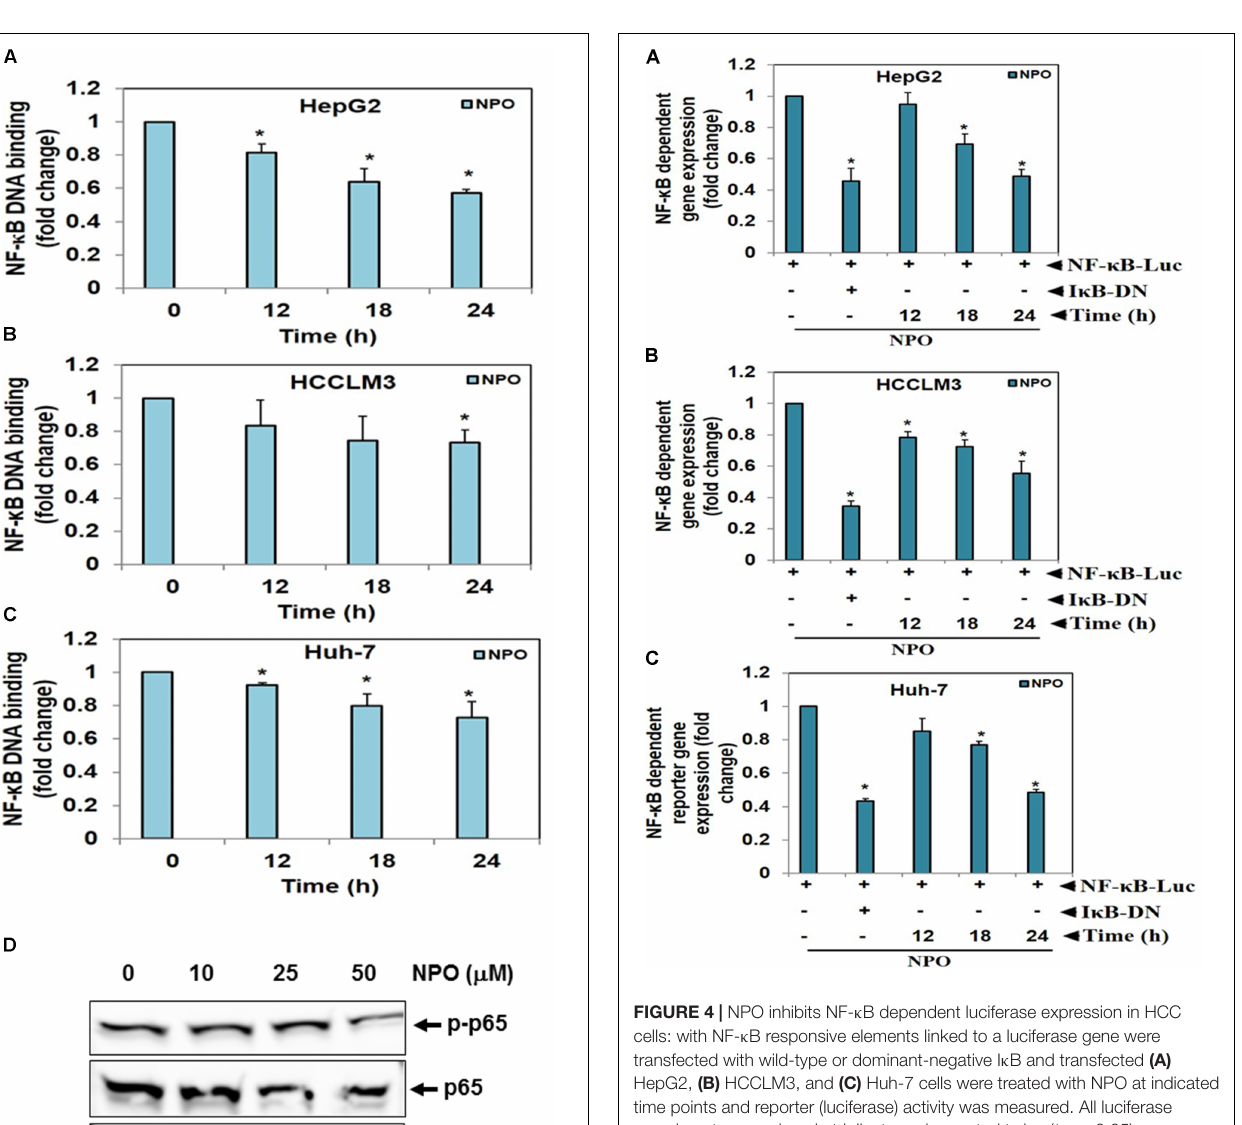
FIGURE 3 | (A–C) NPO downregulates NF- κ B DNA binding ability in HCC cells. HepG2, HCCLM3, and Huh-7 cells were treated with NPO for different time points, nuclear extracts were prepared, and 20 µ g of nuclear extract protein was used for DNA binding assay. The NF- κ B DNA binding was inhibited in time-dependent manner. (D) Effect of NPO on p65 phosphorylation in HCCLM3 cells. Nuclear extracts were prepared as described in Materials and Methods. HCCLM3 cells were treated with NPO at doses of 10, 25, and 50 µ M for 24 h and expression of various proteins was analyzed by western blot analysis. ∗ p < 0.05.